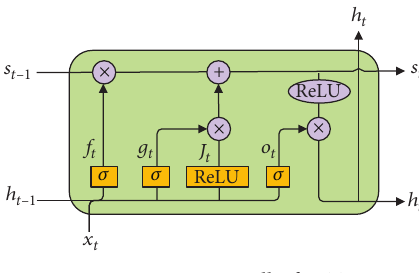
Figure 1: Memory cell of